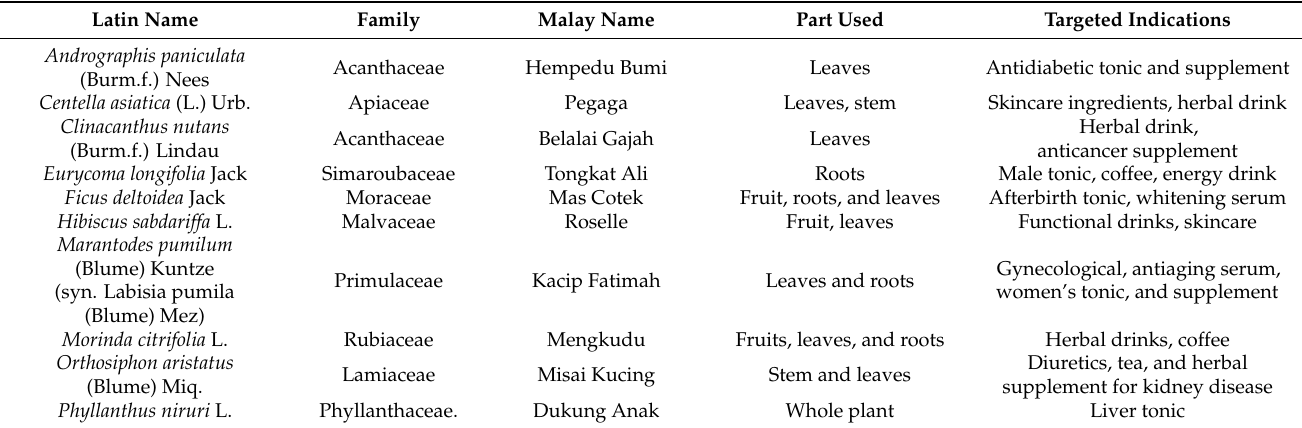
Table 1. Traditional plant species with high economic potential according the Malay National